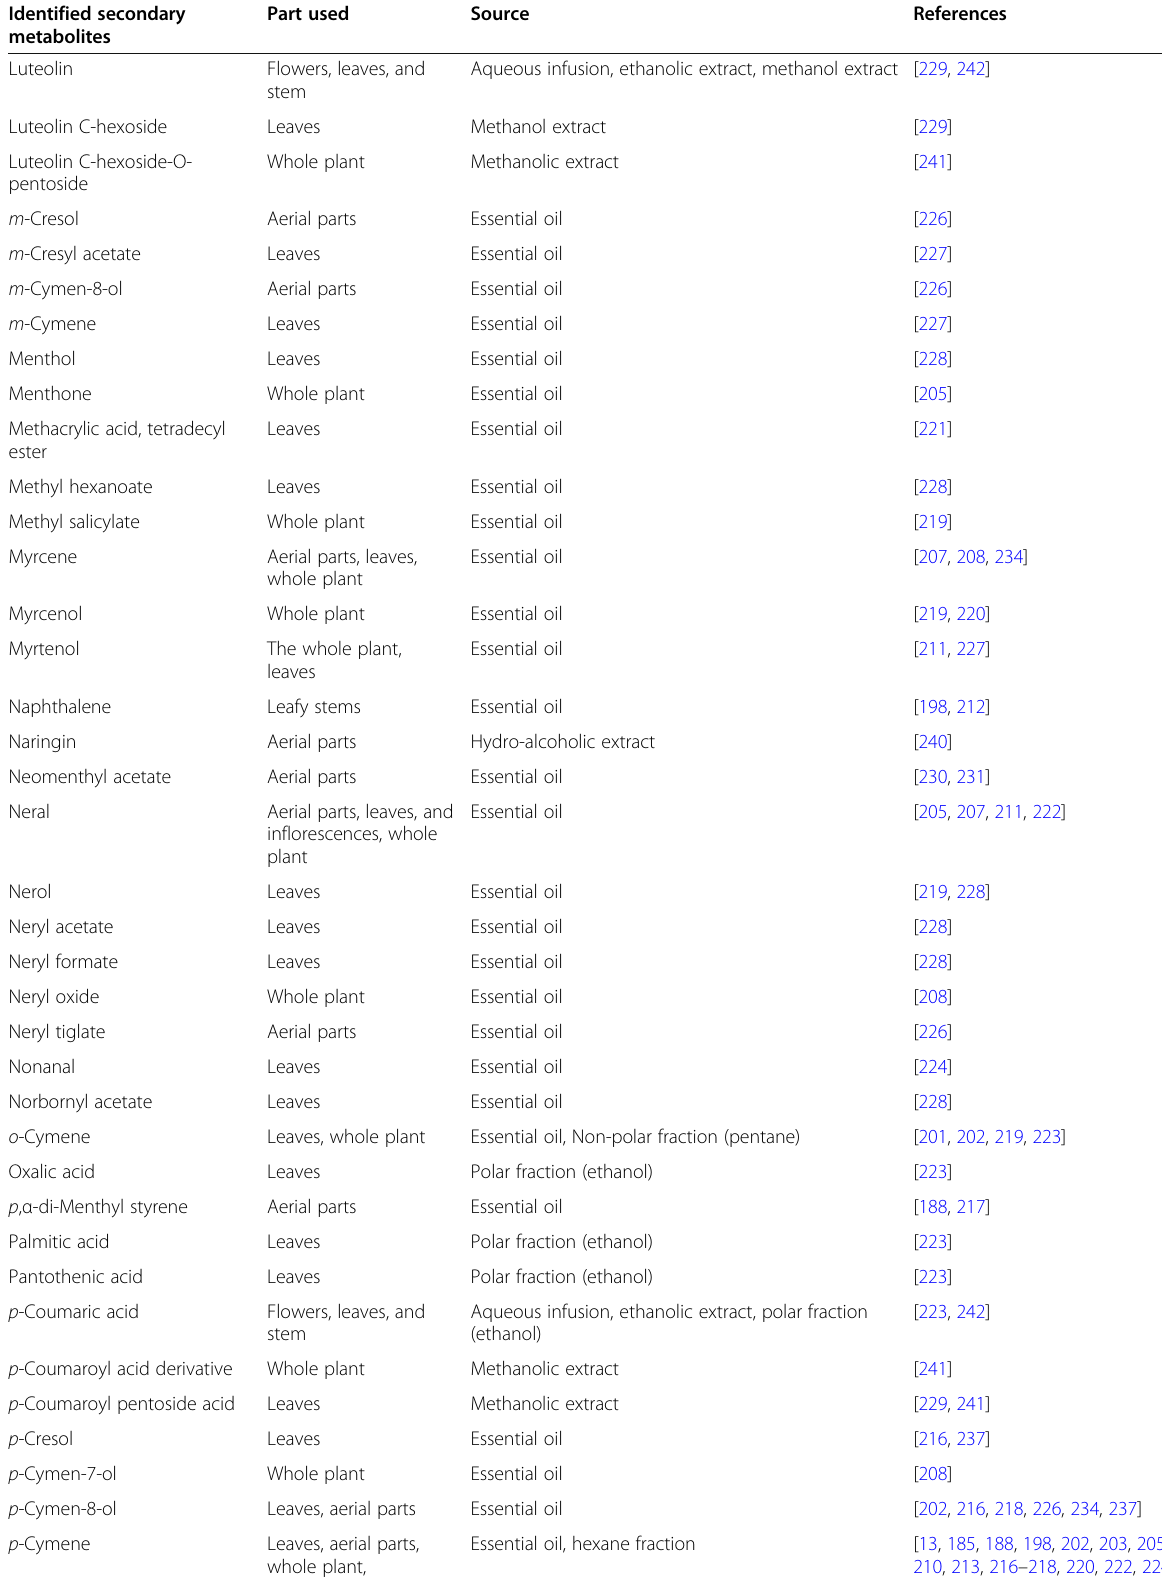
Table 3 Main secondary metabolites identified in C. ambrosioides